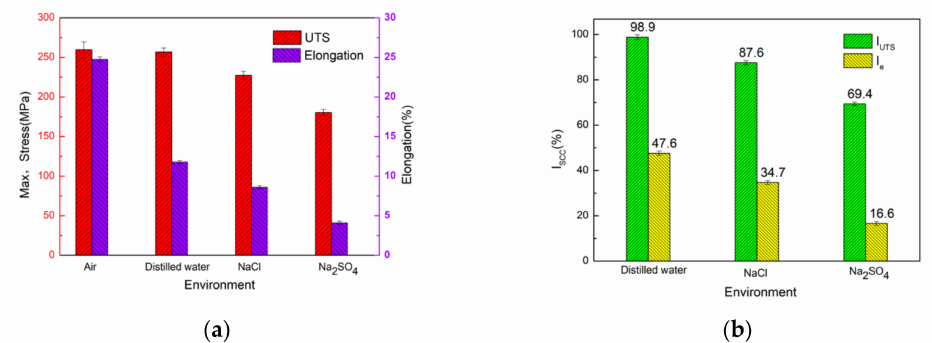
Figure 5. Comparison of the SSRT data ( a ) and SCC susceptibility index ( b ).